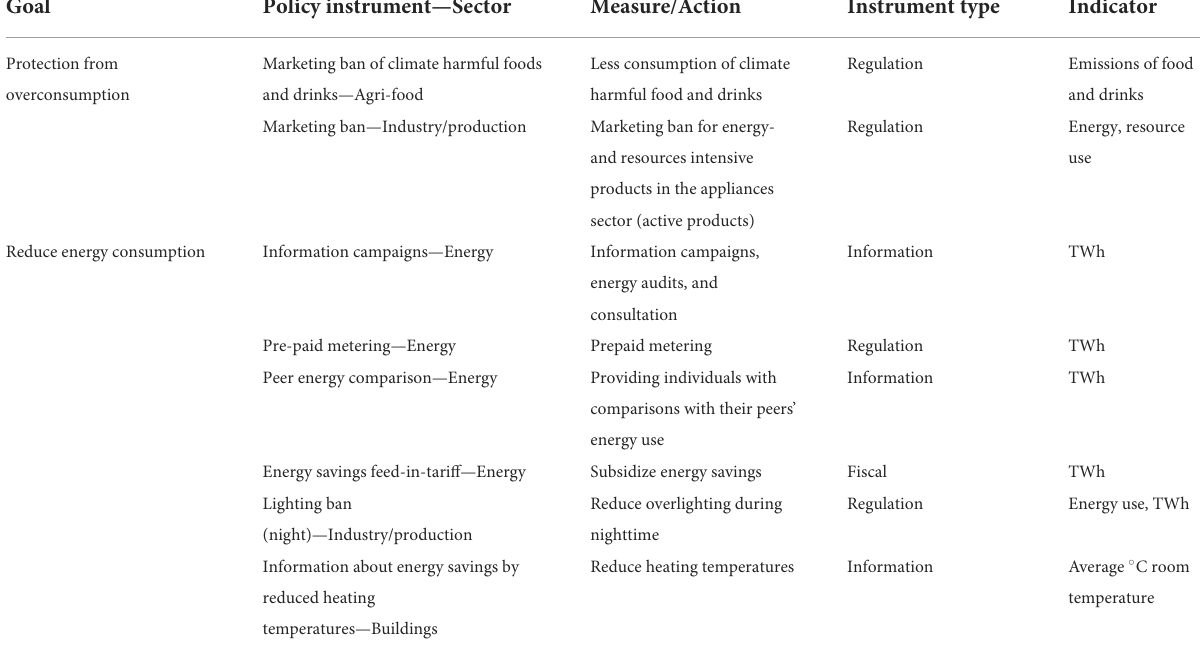
TABLE 1 Examples of sectoral energy sufficiency polices for selected